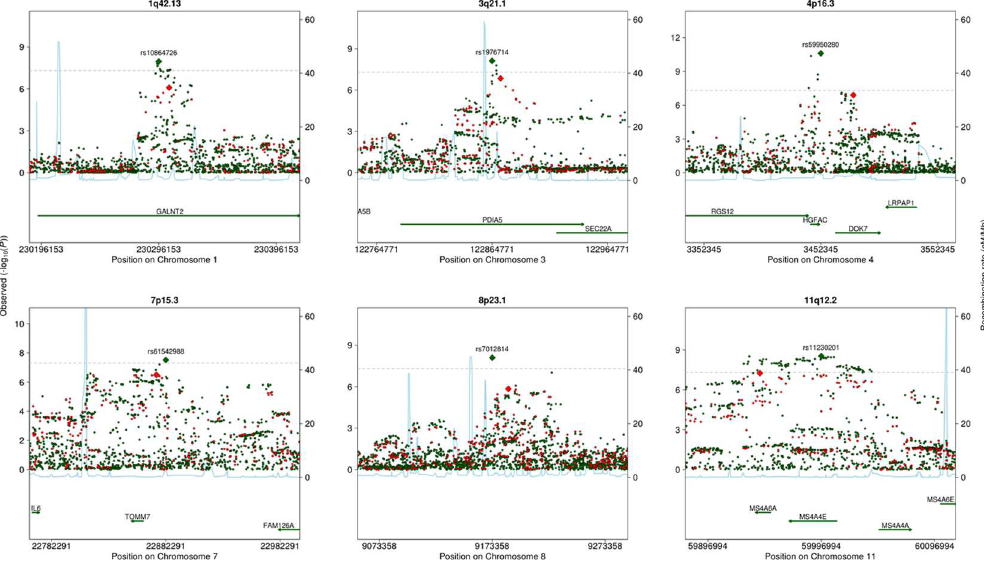
Fig 3. Regional plots of non-overlapping loci that were more significantly associated with fibrinogen in the 1000G GWA study, including variants from both the HapMap (red) and 1000G (green) GWA